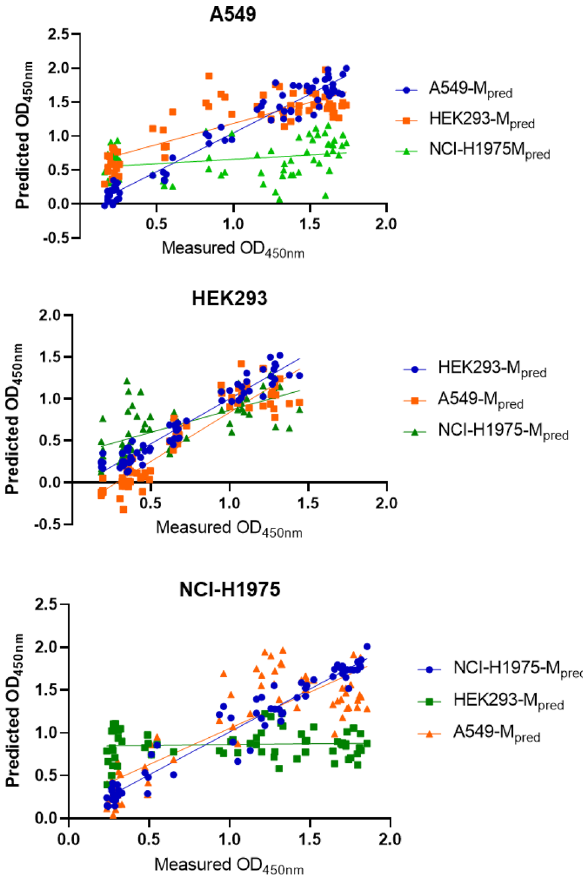
Figure 2. Correlation of measured and predicted optical density measured at 450 nm following colorimetric cell proliferation assay (CCK assay). The models constructed for the three types of cells were A549-M, HEK293-M, and NCI-H1975-M. The predicted values were drawn up from allogenic models as well as autologous models for cross validation. The linearity and statistical analysis results are shown in Table 1.